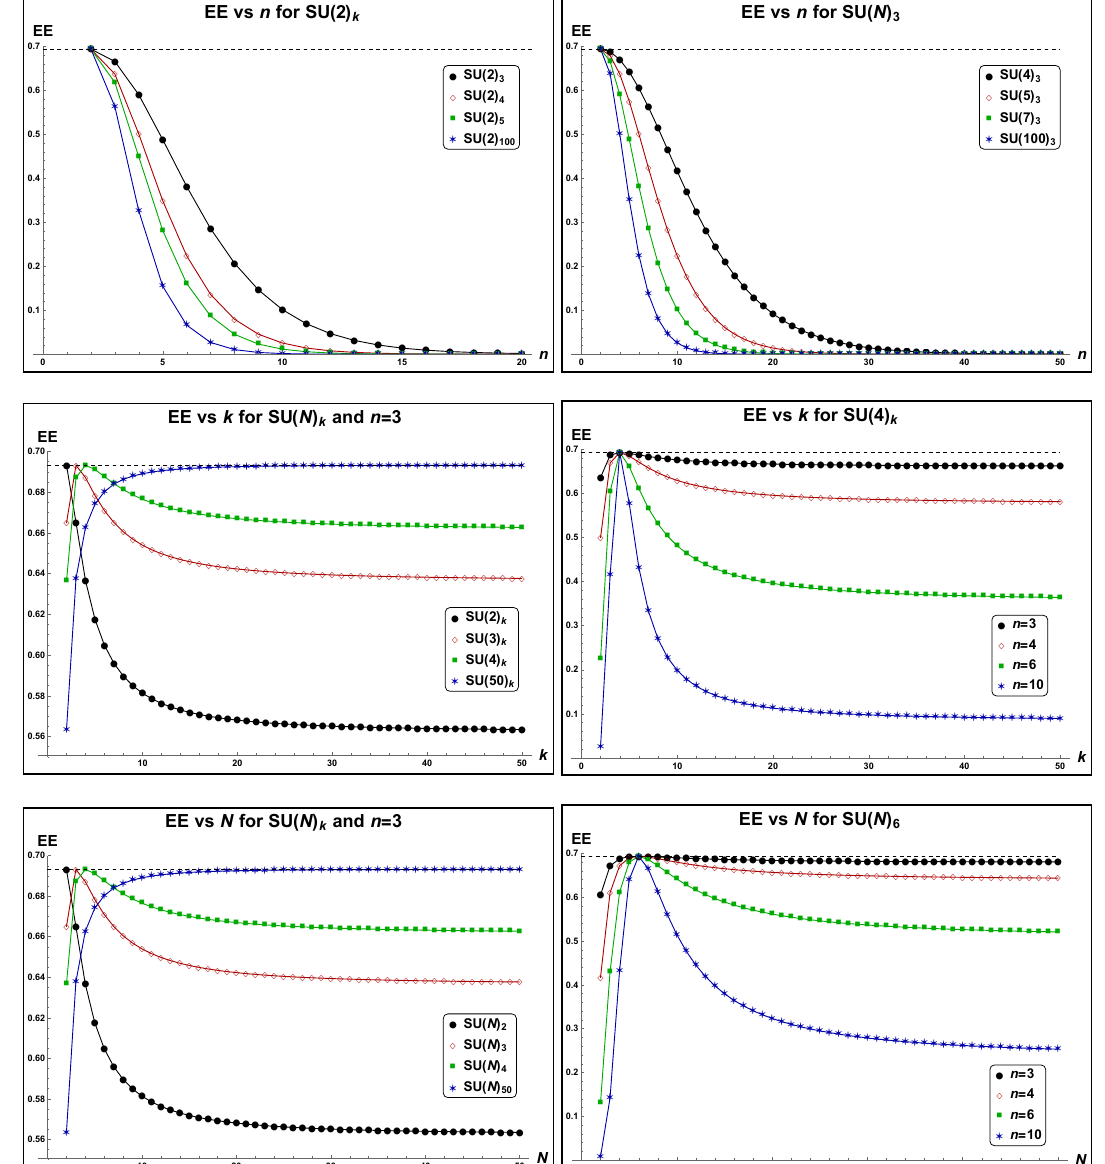
Figure 8 . The variation of SU( N ) k entanglement entropy for the state j (cid:9) lines carry fundamental representation. The horizontal dotted line corresponds to EE = ln 2 which is the maximum possible value for